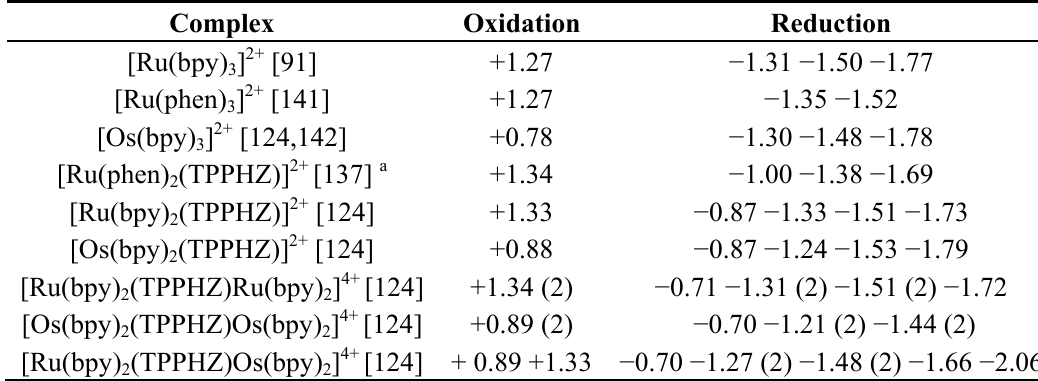
Table 2. Redox potentials E(V) vs. SCE for various ruthenium II complexes. Oxidation values are measured in acetonitrile and reduction potentials are measured in DMF vs. SCE unless otherwise noted. In parenthesis is the number of exchanged